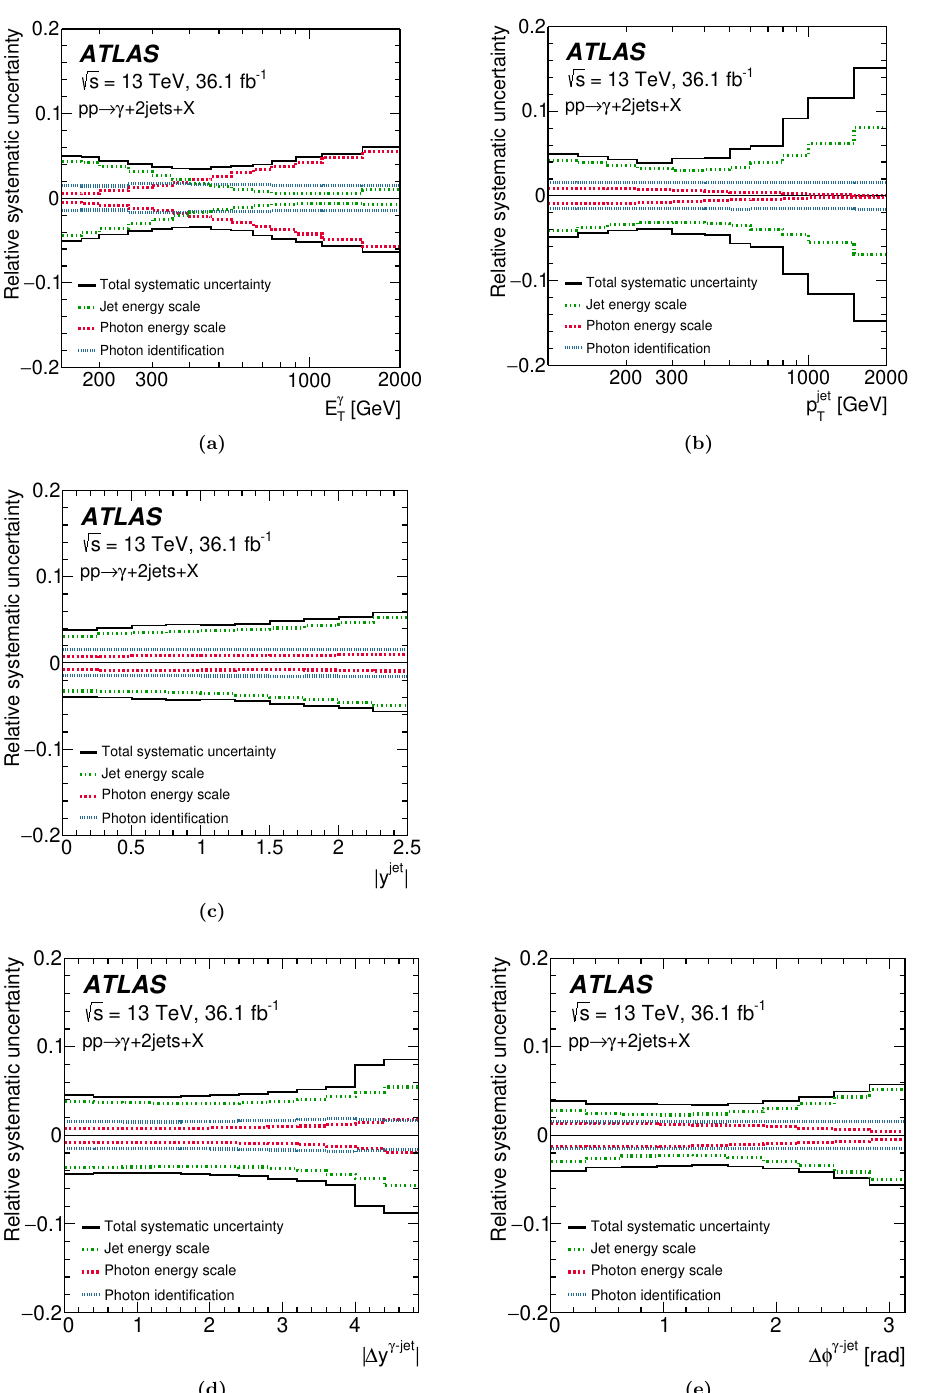
Figure 2 . Total relative systematic uncertainty in the measured cross-sections (black lines), exclud- ing the uncertainty of the luminosity determination, together with the three main contributions, namely jet energy scale (dot-dashed lines), photon energy scale (dashed lines) and photon identi- (cid:12)cation (dotted lines), as a function of (a) E (cid:13) , (b) p jet , (c) j y jet j , (d) j (cid:1) y (cid:13) {jet j and (e) (cid:1) (cid:30) (cid:13) {jet for T T the total phase